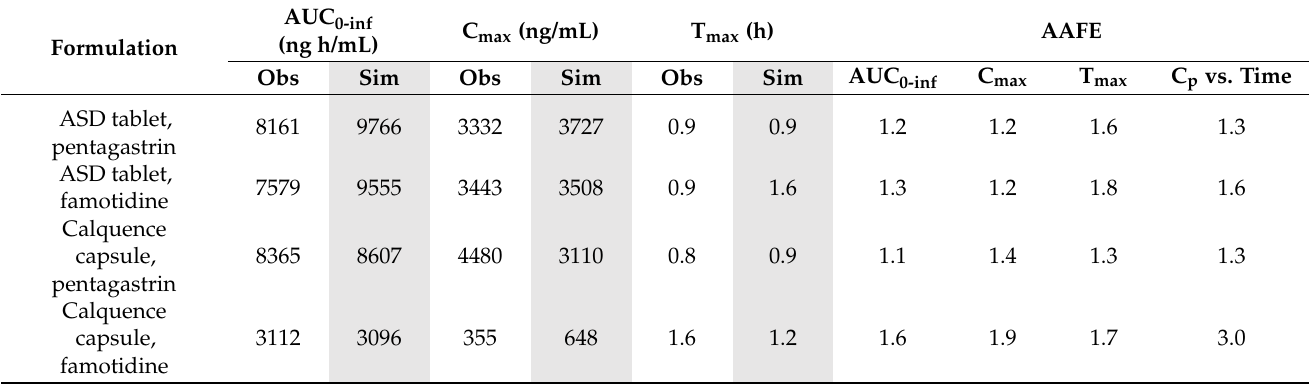
Table 4. Noncompartmental analysis comparing simulated (sim) versus observed (obs) data for all formulation treatments in the dog study. Absolute average fold error (AAFE) was calculated for AUC 0-inf , C max , T max , and C p versus time to determine the accuracy of the in silico prediction exercise (ideal value =